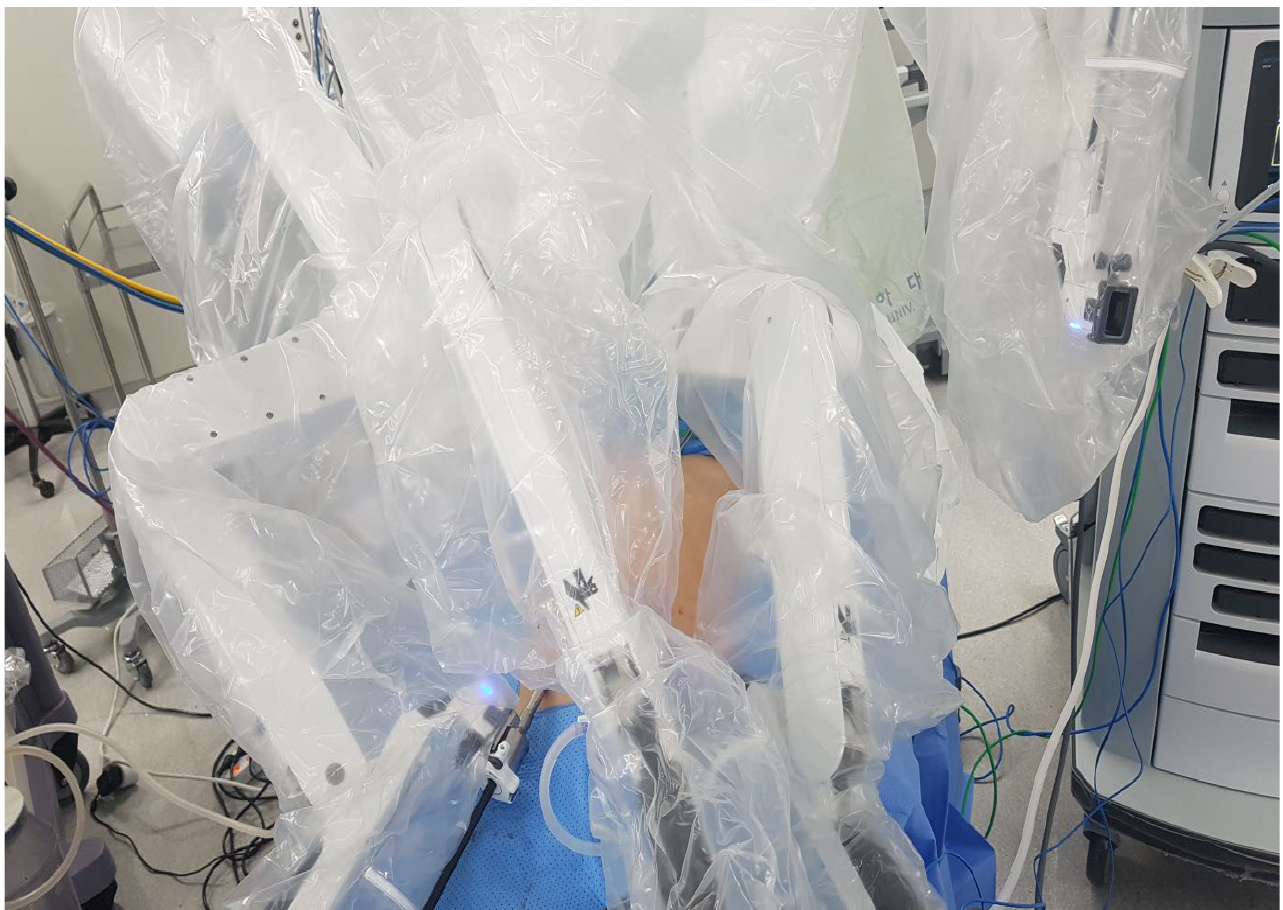
Figure 2. Robotic-assisted TAPP inguinal hernia surgery docking status.